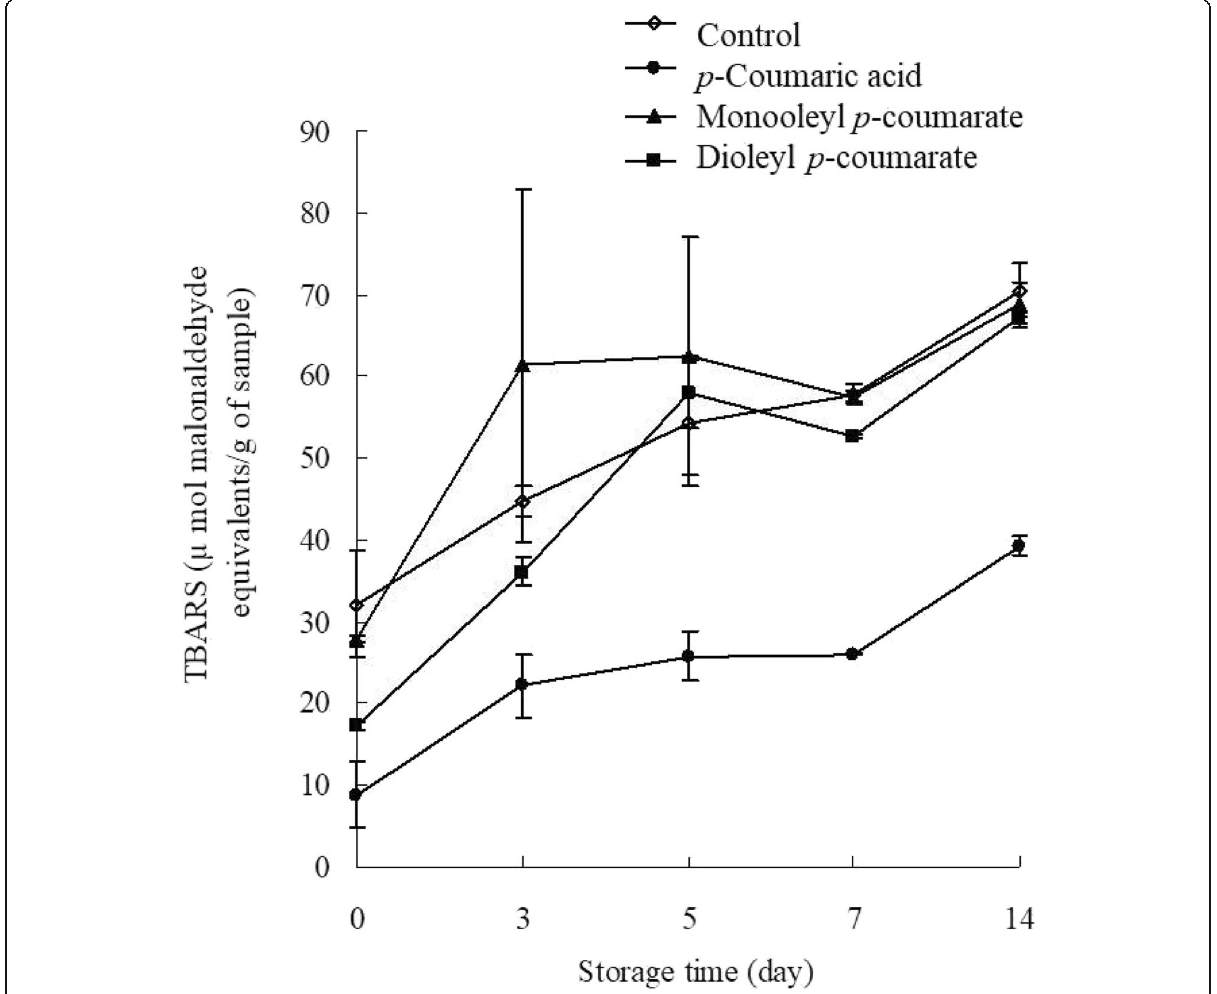
Fig. 6 TBARS values in cooked ground pork as affected by p -coumaric acid, mono- and dioleyl p